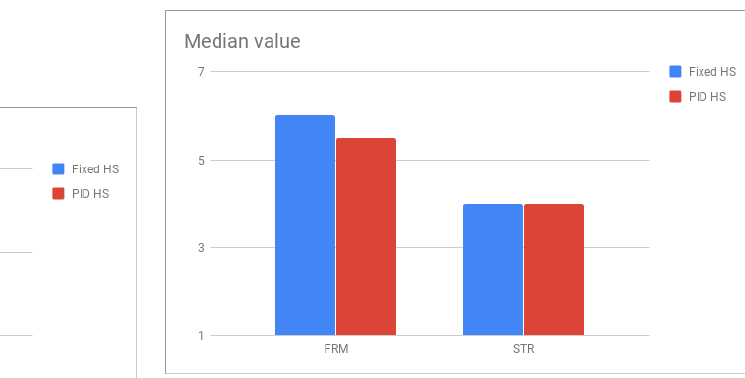
Figure 12: Median values for firmness and strength